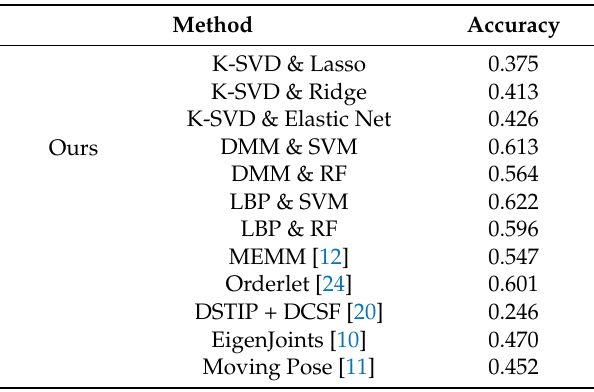
Table 3. Comparison on the MSR Daily Activity 3D